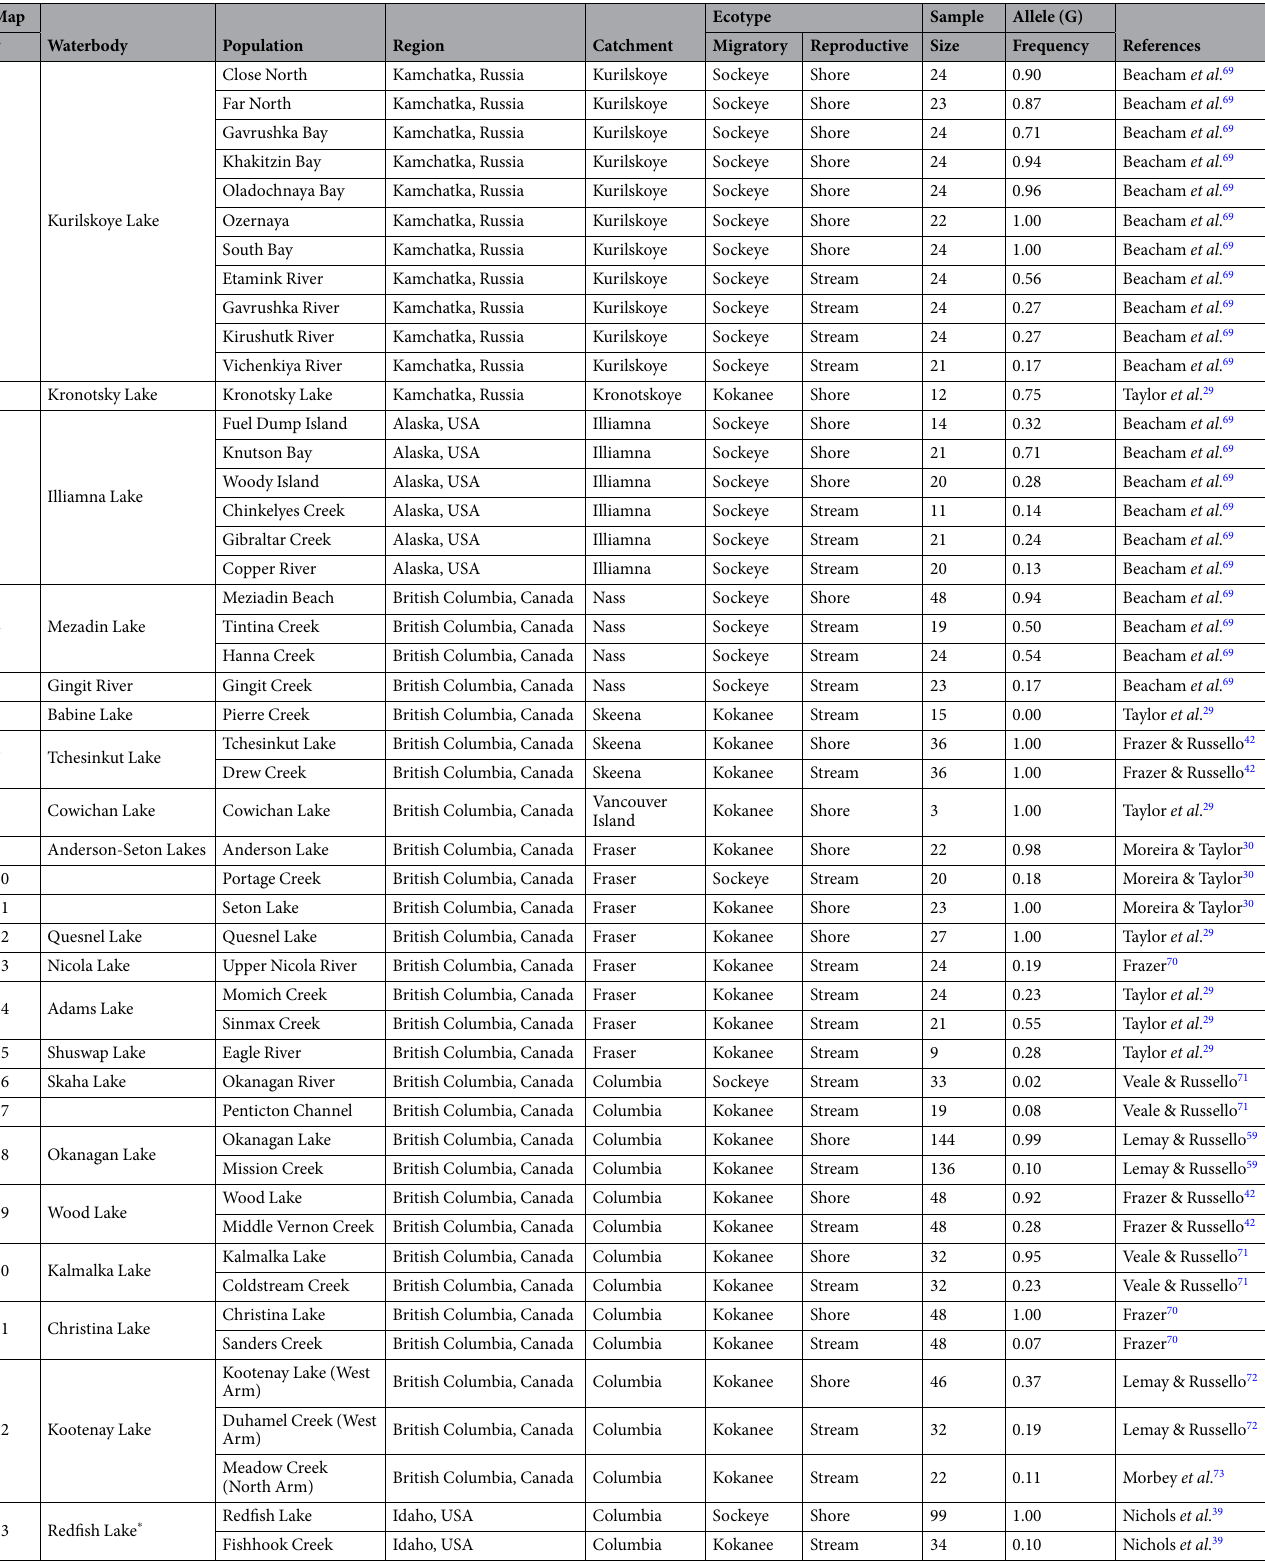
Table 1. Range-wide sampling information of Oncorhynchus nerka . * Allele frequency data from Nichols et al . 39